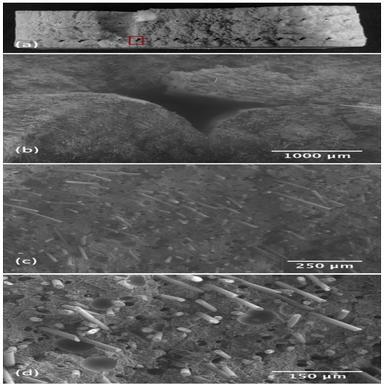
Images of fracture surface of specimen 5, (a) photograph of a print gap, (b–d) SEM images of the fracture surface.